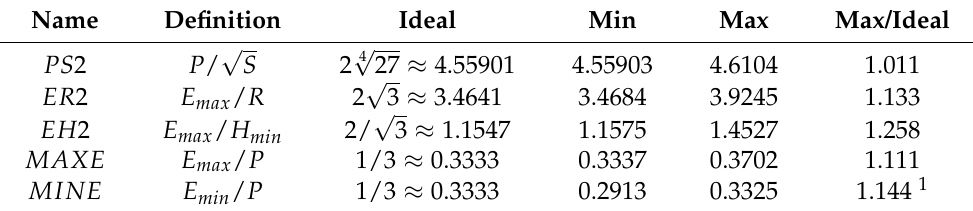
Table 1. Geosphere model surface mesh